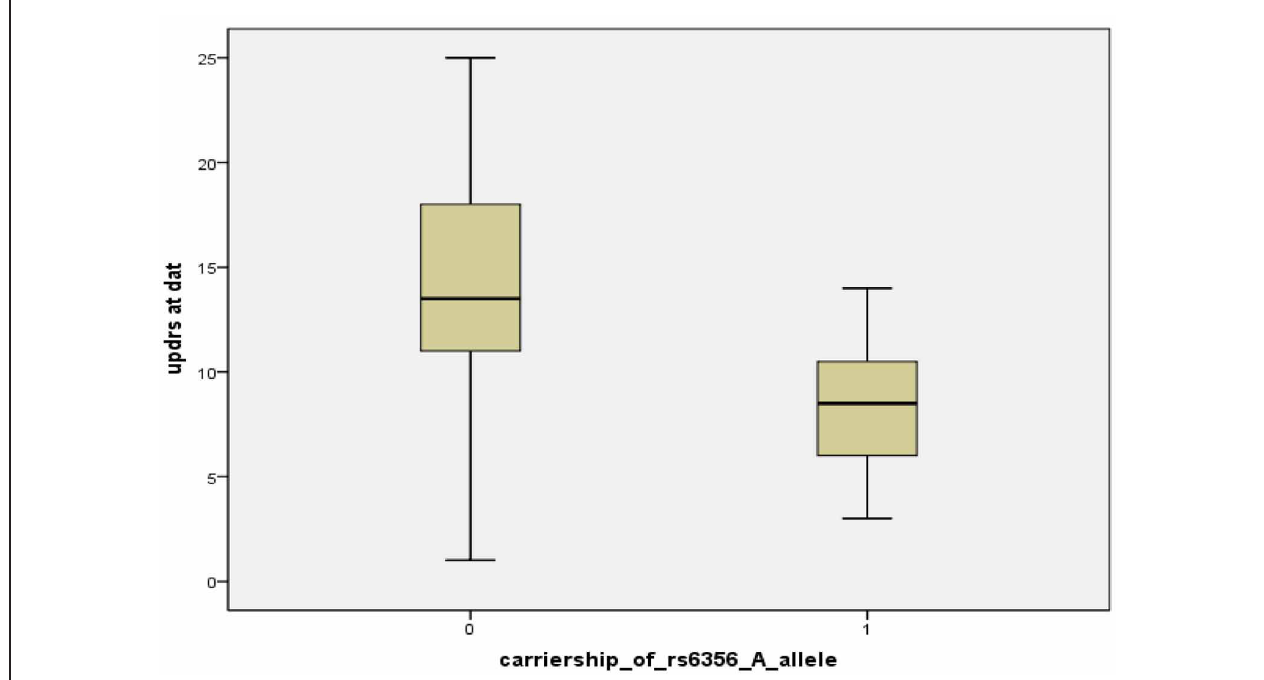
FIGURE A1 | Boxplot of UPDRS scores at DAT scan, classified by carriership of the rs6356 “A” allele [“0” means non-carriers of “A” allele ( n = 8), “1” means carriers “A” allele (AA or AG genotype) ( n = 20)].